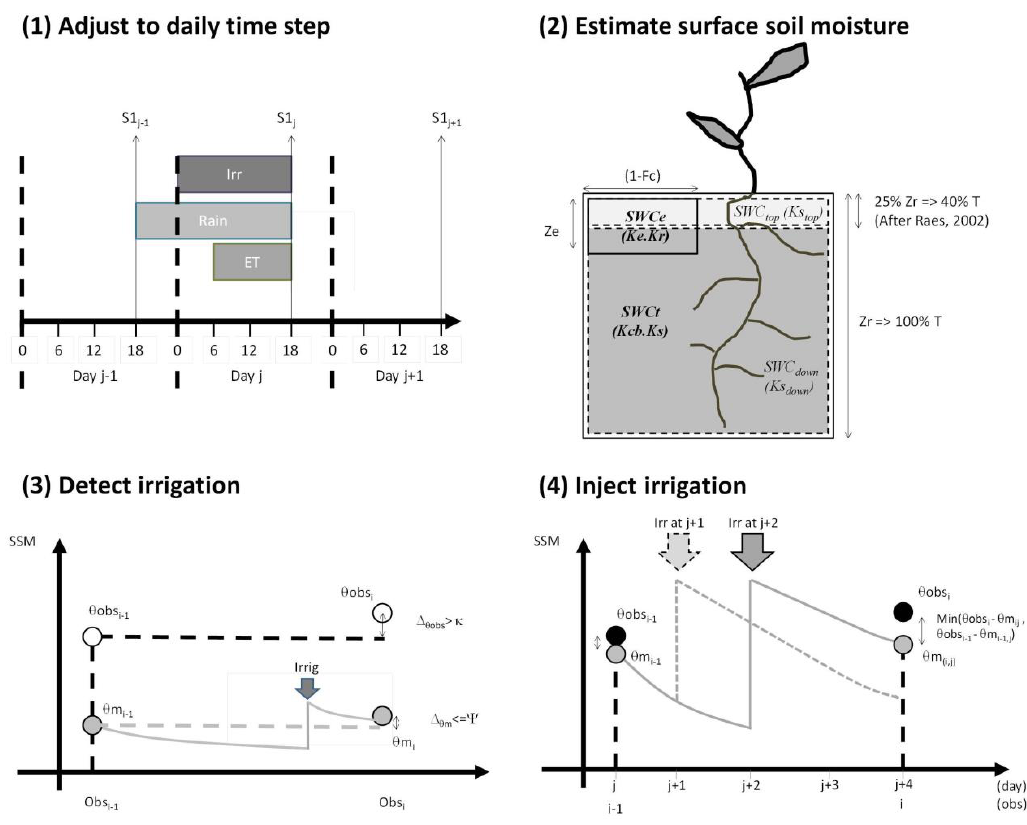
Figure 3. The four steps used to estimate irrigation dates.